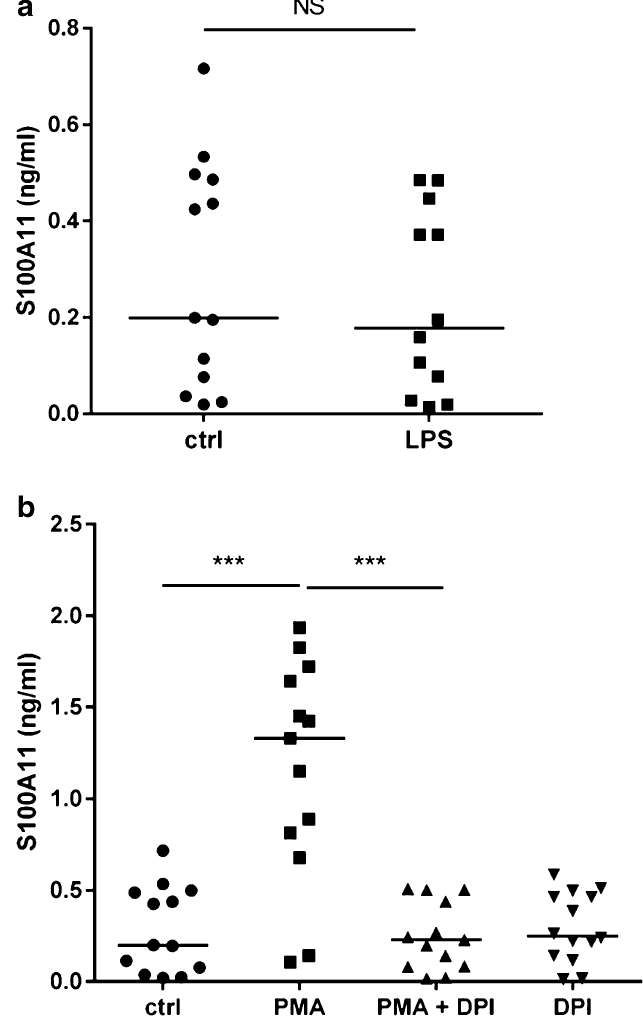
Figure 3. Neutrophils from RA patients exposed to lipopolysaccharide (LPS) did not exhibit increased S100A11 secretion compared to unstimulated neutrophils (4 h), ( a ). Stimulation of NETosis by phorbol 12-myristate 13-acetate (PMA) for 4 h upregulated the secretion of S100A11 by neutrophils. Pretreatment with diphenylene iodonium (DPI) before PMA eliminated the formation of NETs and thereby the release of S100A11 ( b ). Ctrl unstimulated control, NS non-significant. The horizontal line represents the median. ***p <